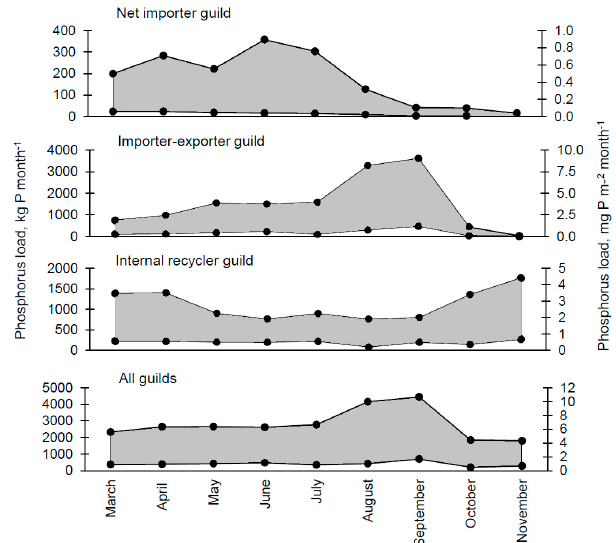
Figure 3. Monthly P loads produced by different nutrient cycling guilds of birds. Grey area represents ranges of possible loads. Note that the scales are different for the figures.